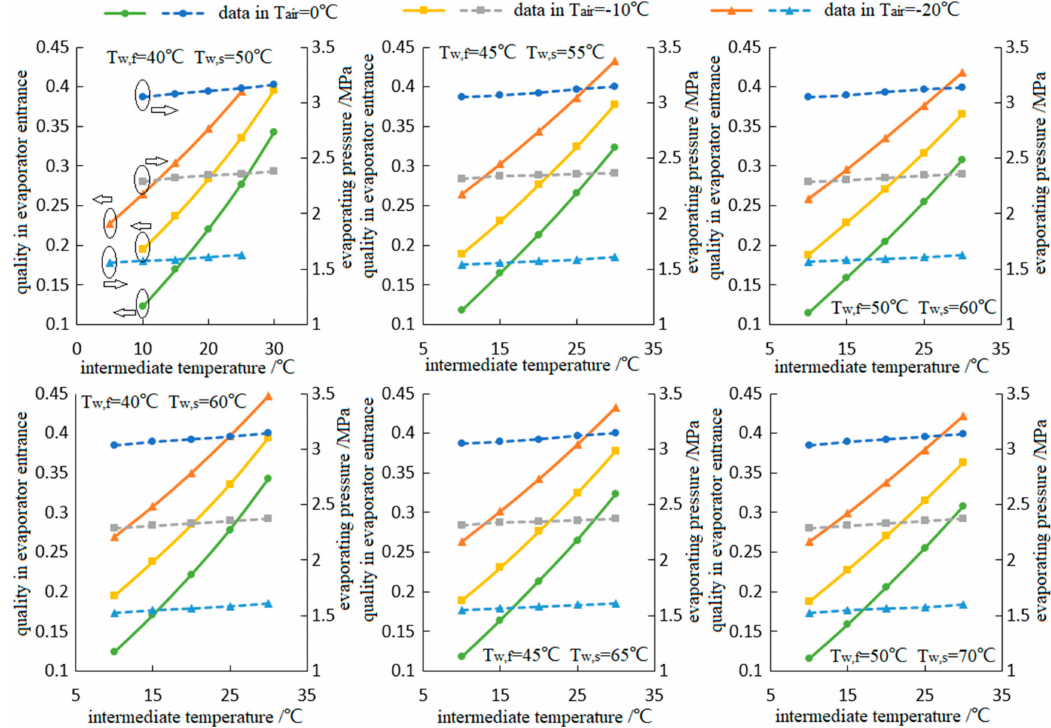
Figure 8. The evaporator entrance quality and evaporating pressure in main cycle versus the intermediate